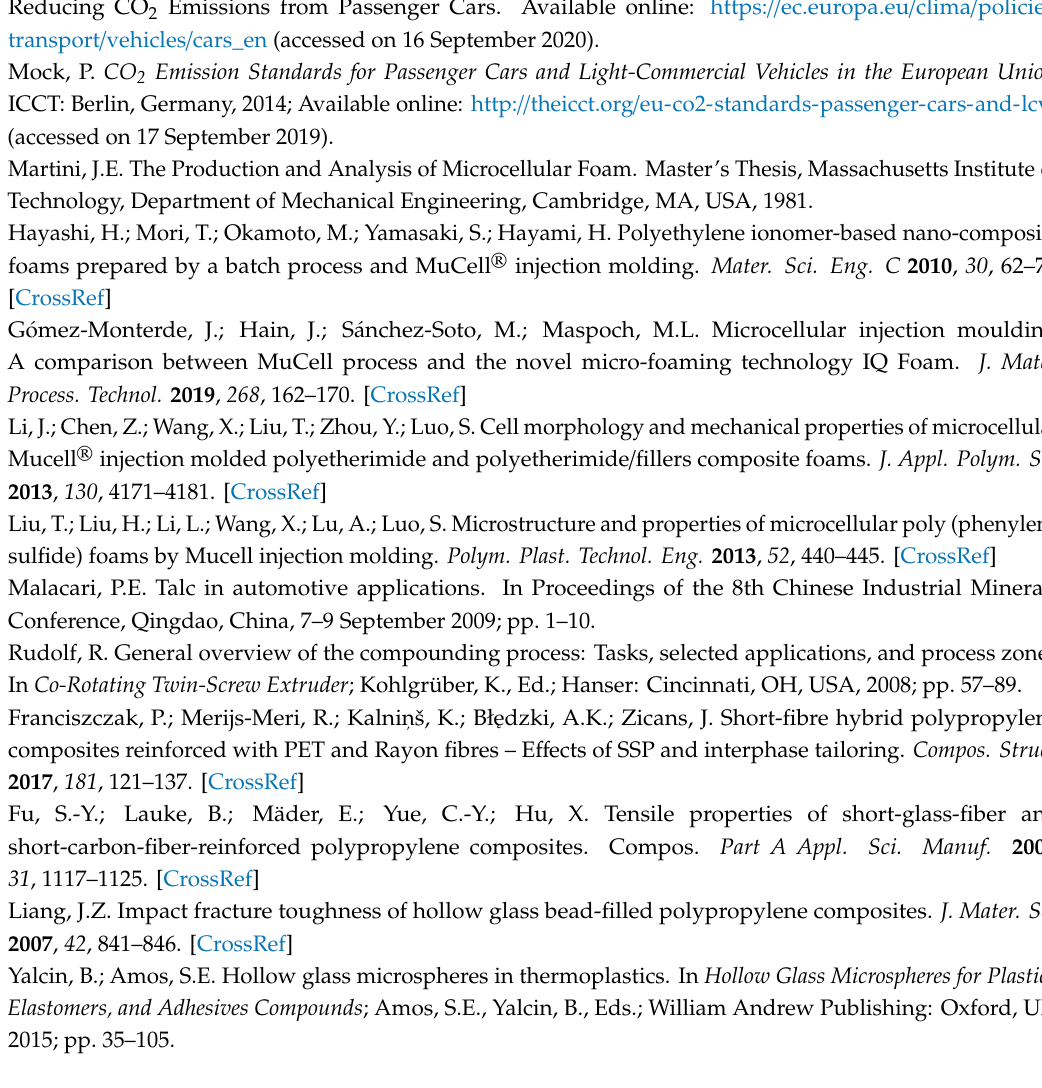
Table S1: The mechanical properties of PP Neat using conventional injection